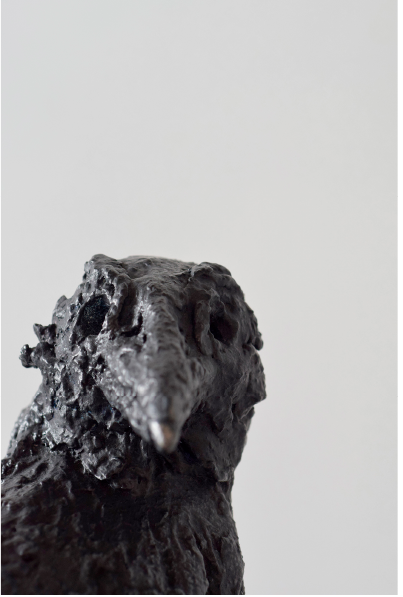
Figure 2. Crow (2020), Alternator Studio. Ceramic, 25 × 45 × 19 cm.